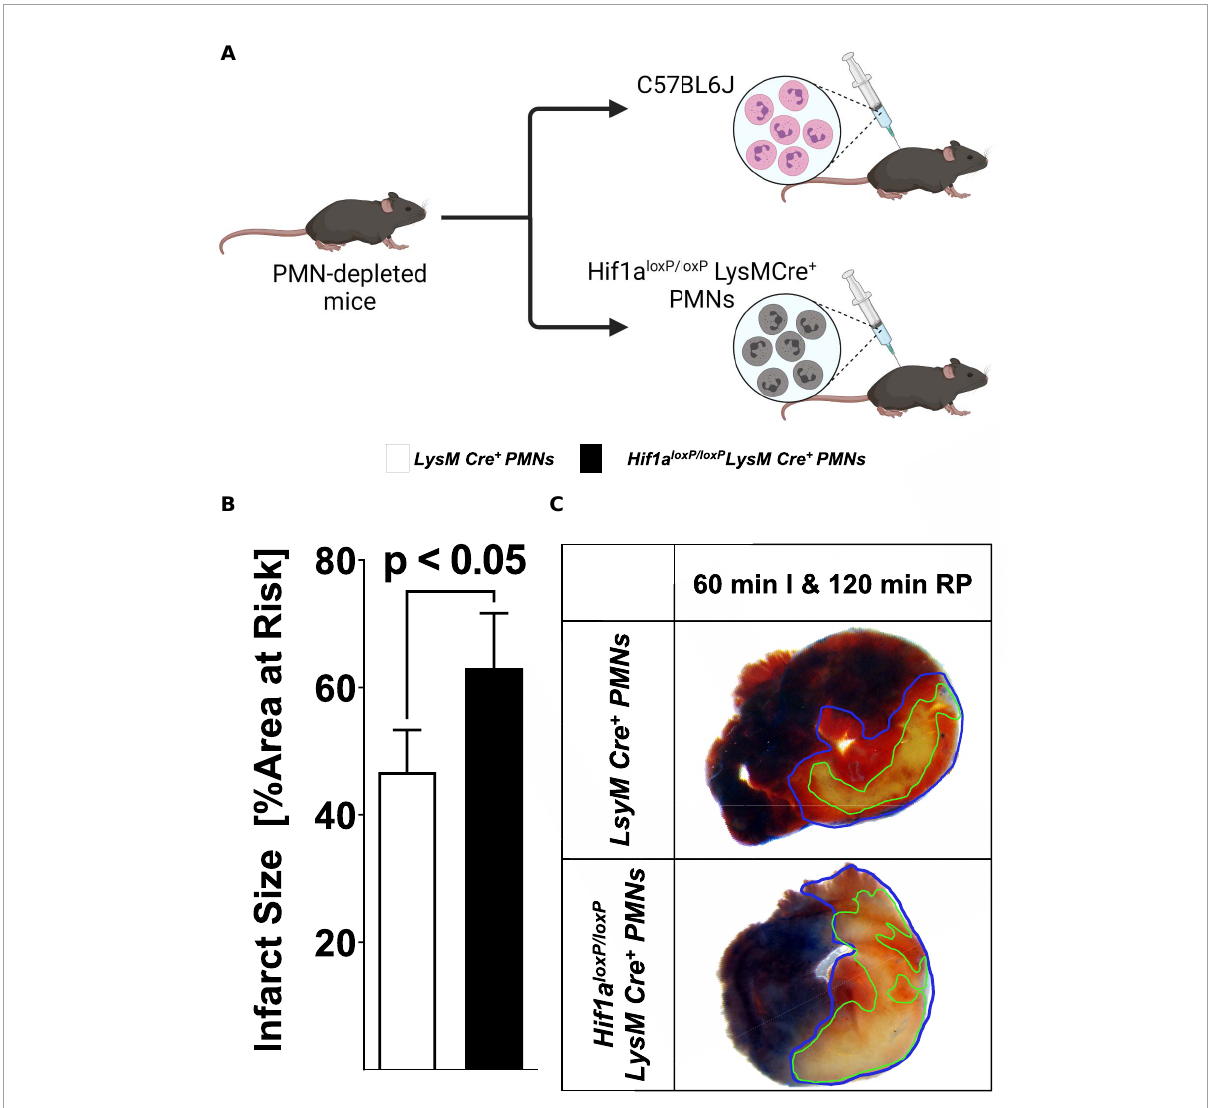
FIGURE3 Effects of adoptive transfer of polymorphonuclear neutrophils (PMN) from Hif1a loxP / loxP LysM Cre+ to wild-type mice during myocardial ischemia and reperfusion injury. (A) Schematic of adoptive transfer model. PMNs deficient in C57BL6J or Hif1a-deficient PMNs ( Hif1a loxP / loxP LysM Cre+) were isolated by negative selection and transferred to PMN-depleted C57BL6 animals (1A8 Ly6G specific antibody 24 h prior to experiment). The animals were then subjected to 60 min of ischemia, followed by 120 min of reperfusion with assessment of myocardial injury. (B) Infarct sizes ± SD in mice receiving PMN from C57BL6J or Hif1a loxP / loxP LysM Cre+ mice presented as a percentage of the area at risk after 60 min of ischemia, followed by 120 min of reperfusion (LysM Cre+ PMNs n = 4; Hif1a loxP / loxP LysM Cre+ n = 4; all values represented as mean ± SD; statistical significance evaluated by two-sided, unpaired Student’s t -test). (C) Representative infarct staining of neutrophil-depleted mice receiving PMNs from LysM Cre+ or Hif1a loxP / loxP LysM Cre+